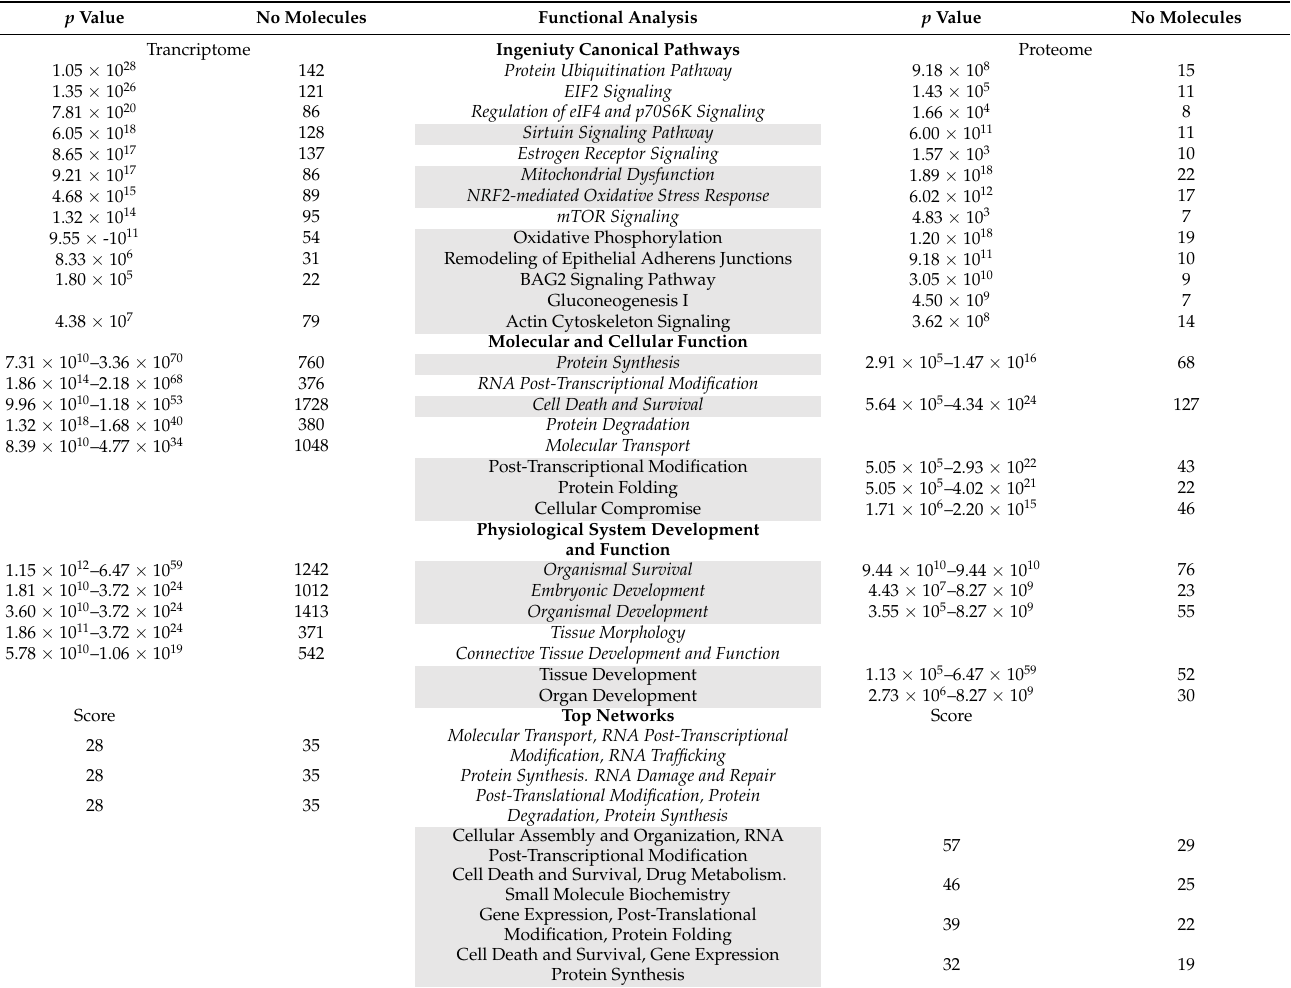
and sirtuin signaling pathway (Table 2, and Supplementary Materials, Table S2). Molecular and cellular functions and the most significant physiological functions are presented in Table 2. Table 2. Results from Ingenuity Pathway Analysis of Turkey Inner Perivitelline Layer Transcripts and Proteins. p